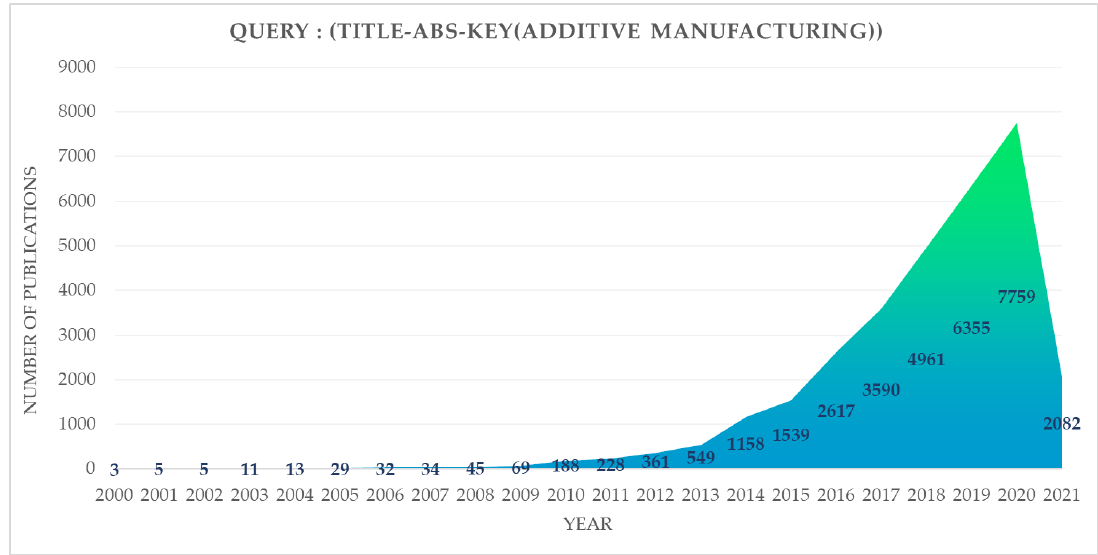
Figure 1. Evolution of publications number regarding additive manufacturing (AM), based on Scopus database and query (TITLE-ABS-KEY(additive manufacturing)). Accessed on 18 March 2021.